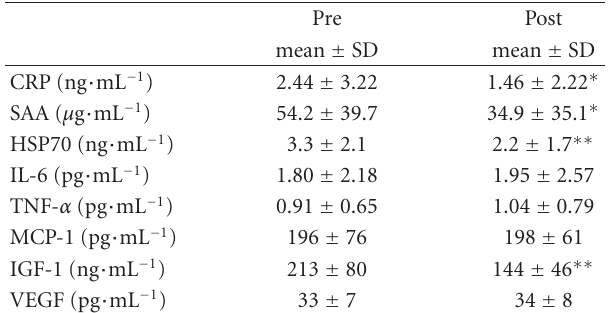
Table 3: Changes in inflammatory markers pre and post exercise training in elderly women ( n = 21).